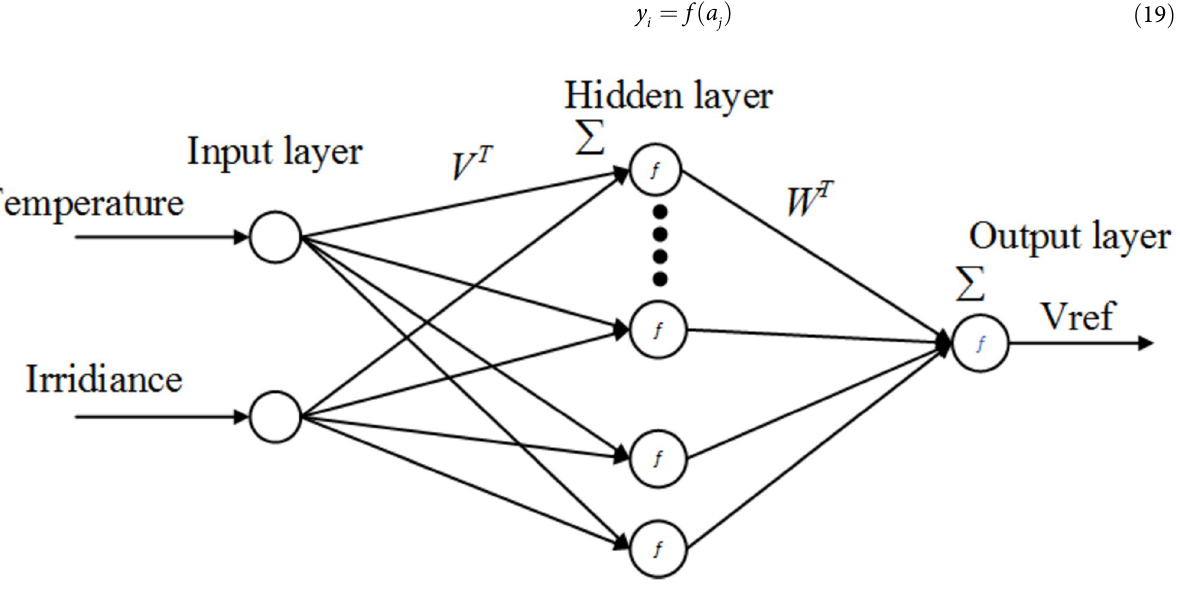
Fig 7. Neural network for V ref